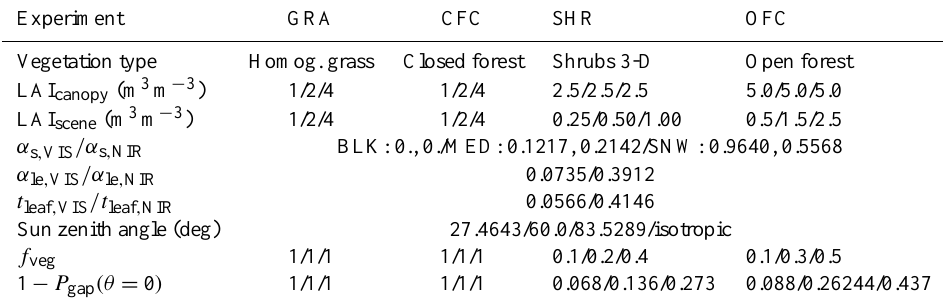
Table 1. Summary of experiment parameters (see Wildowski et al., 2011, for details); different soil backgrounds are specified as BLK=black, MED=Medium, SNW=snow, difference canopy types are specified as GRA=grassland, CFC=closed forest canopy, SHR=shrubland, OFC=open forest